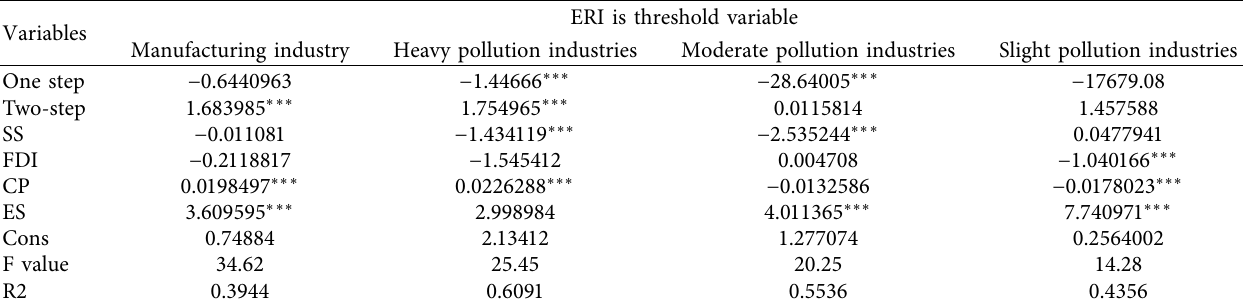
Table 7: Test results for the threshold effects of manufacturing and